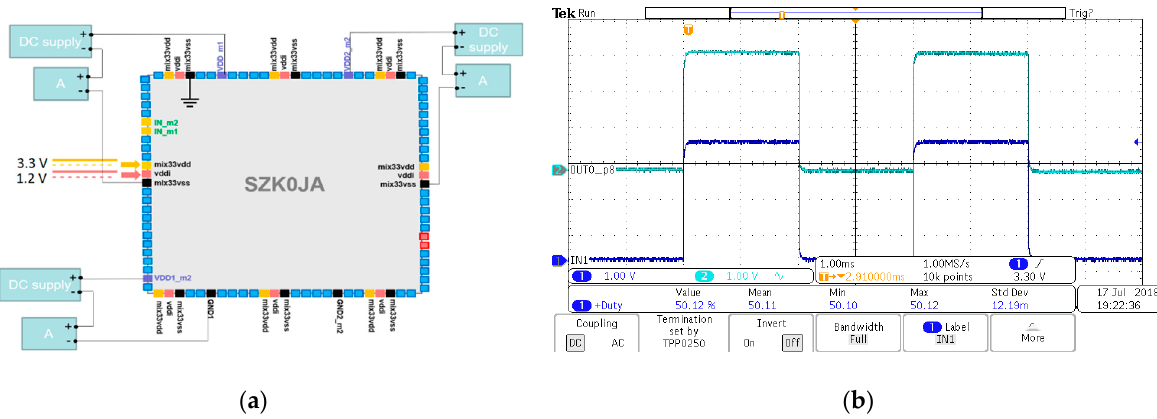
Figure 9. ( a ) Test setup used for functionality verification; ( b ) oscilloscope image of the transient result for input and output pins corresponding to the eighth row of the module.